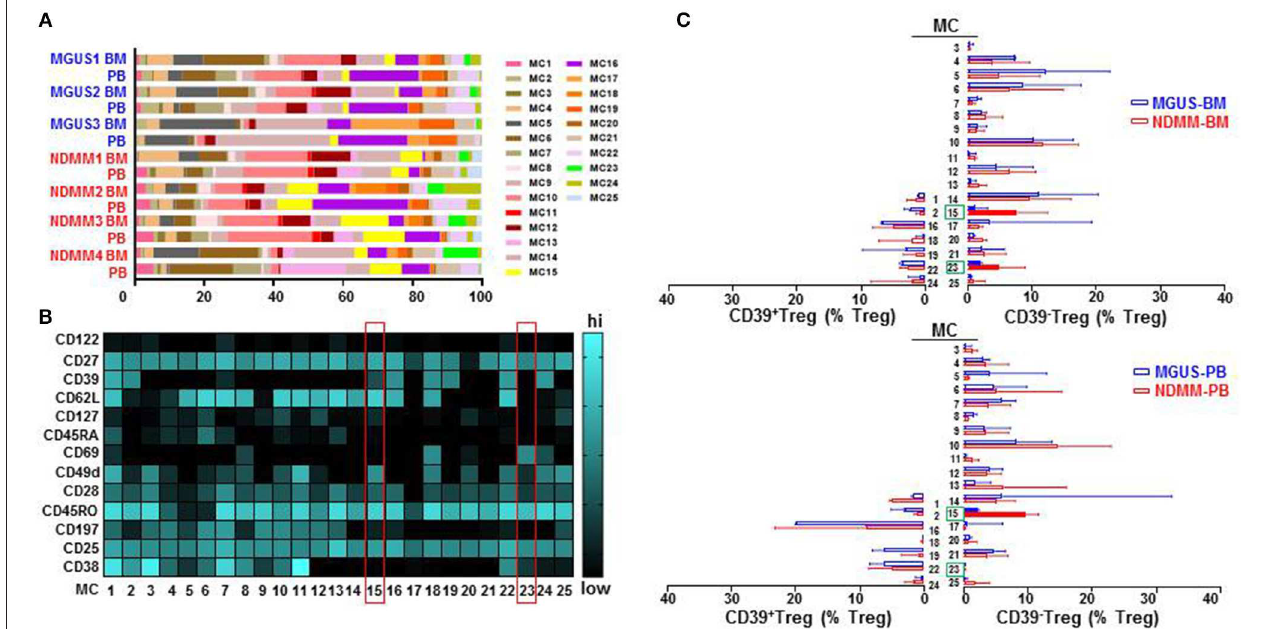
FIGURE 3 | Treg compartment of MGUS and NDMM patients displayed in 25 phenotypically different MC generated by the FlowSOM. (A) Inter-patient heterogeneity for each sample is represented by a horizontal bar in which segment lengths represent the frequency of the Treg assigned to each MC, colored according to the accompanying legend. (B) Heatmap of median signal intensity of indicated surface markers (rows) and MC (columns) summarizing the 25 different phenotypes within the Treg compartment generated by FlowSOM (seed A). The phenotypes of Treg in MC15 and MC23 are indicated on the heatmap (red rectangles). (C) Horizontal bars are frequency of Treg in each MC. MC occupied by CD39 + Treg (left) and by CD39 − Treg (right); MC15 and MC23 are indicated (closed bars, green rectangles). Bars are medians with interquartile